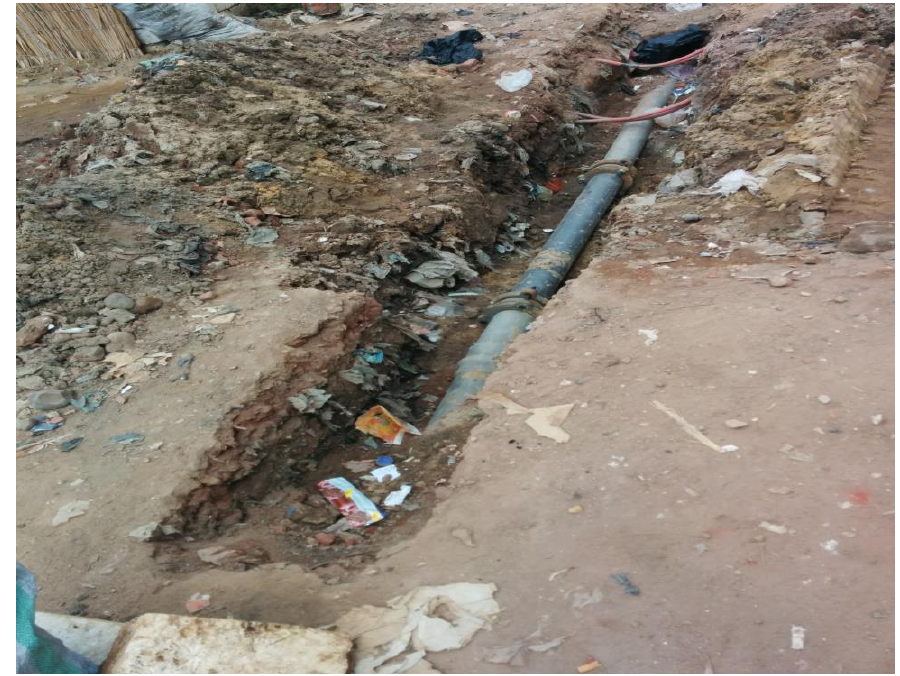
Figure 2. Self-built infrastructure. Source: